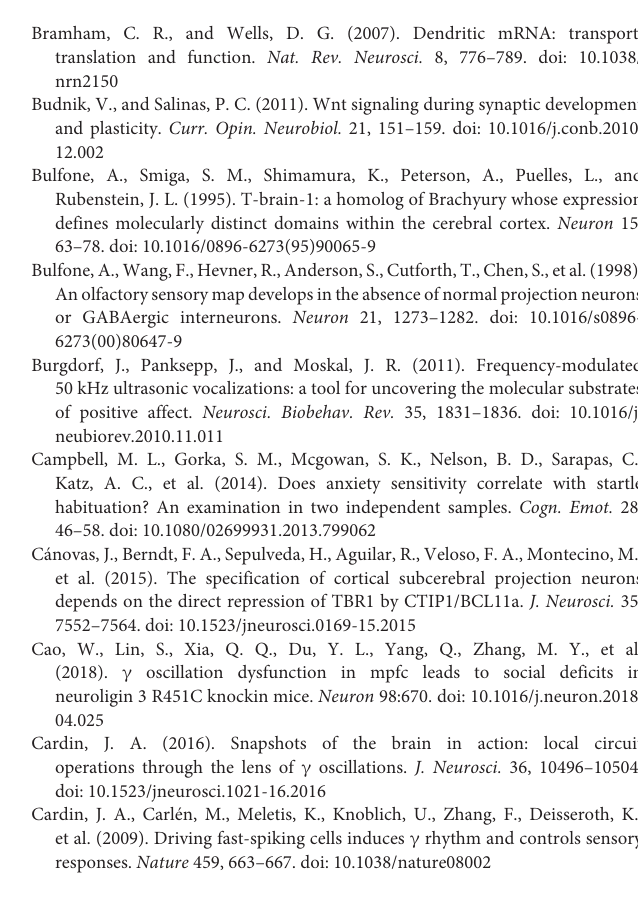
TABLE S2 | Statistical